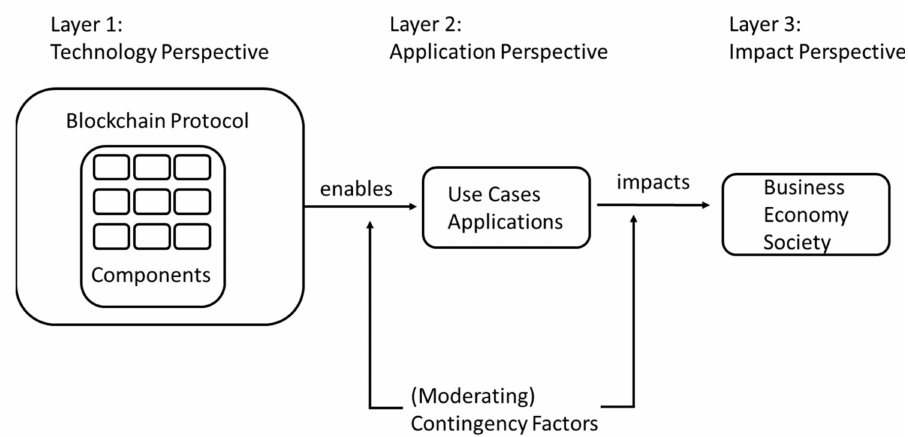
Figure 1. A layered model for blockchain